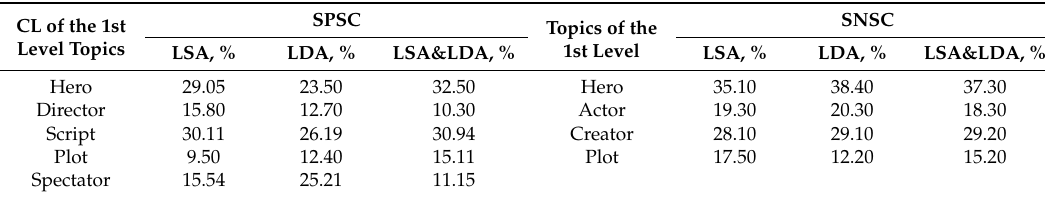
Table 12. Hierarchical Structure of the Contextually-Oriented Corpus.